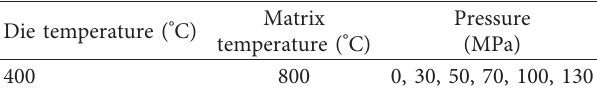
Table 2: Process conditions for